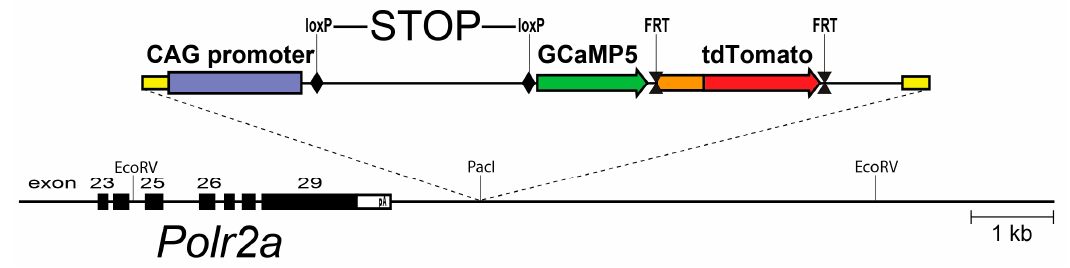
Figure 1. A schematic diagram of the PC::G5-tdT reporter allele in the Polr2a locus. The reporter cassette was inserted 3 ′ of the last exon, without disturbing gene function. Following Cre/loxP-mediated excision of the transcriptional STOP sequence, the CAG promoter drives GCaMP5G and IRES-tdTomato expression in the Cre-expressing cells (e.g., Aif1 (Iba1)-IRES-Cre directs expression to the myeloid-monocytic lineage). If red fluorescence is not desirable, the IRES-tdTomato reporter can be independently removed with FLP recombinase using the FRT sites. Modified from [60].